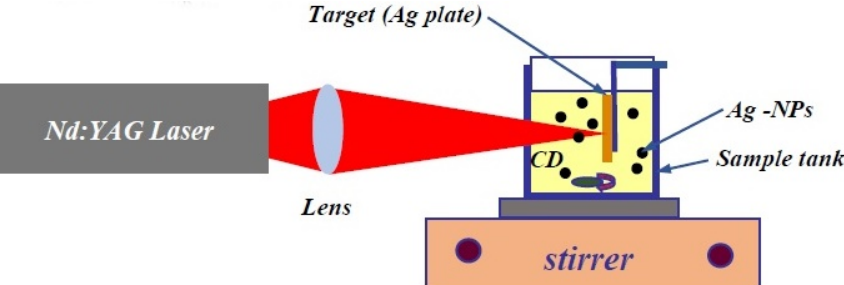
Figure 12. The preparation of Ag–NPs in the CD solution using laser ablation setup. The set up contains a high-power laser, a lens, a stirrer, a sample tank, and a target.